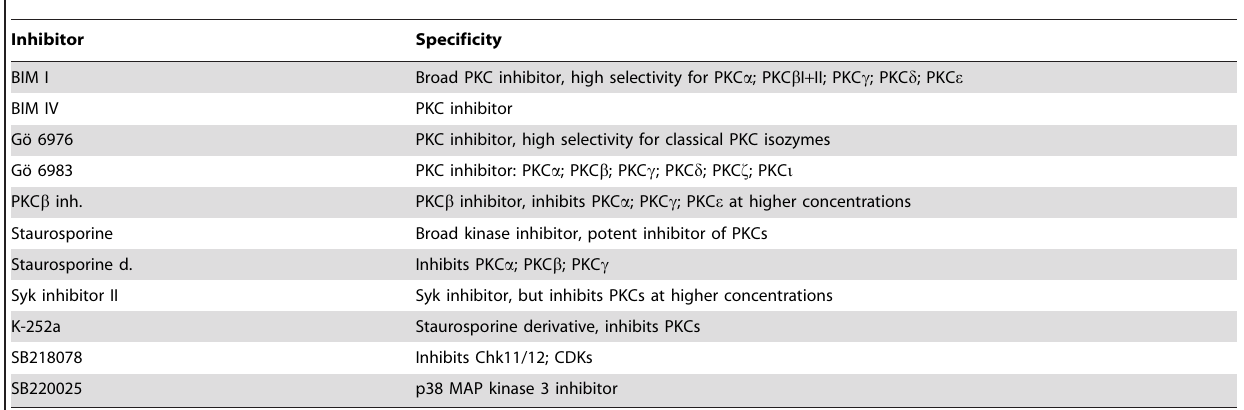
Table 3. Specificity of inhibitors identified from InhibitorSelectTM Library I and II.